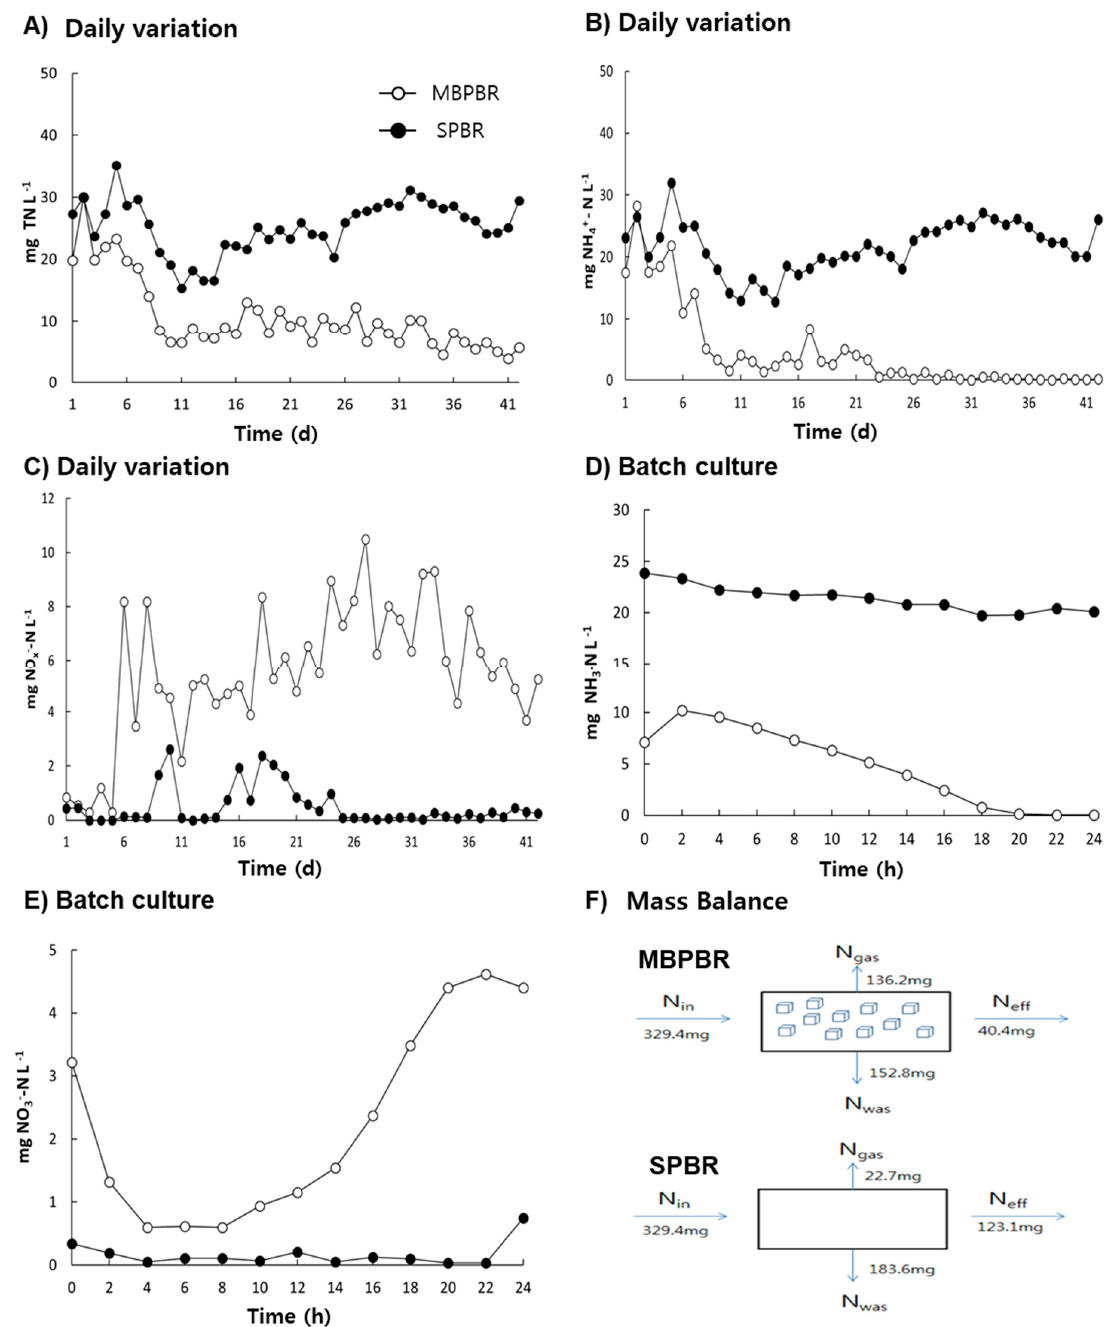
Figure 4. Daily variation in the effluent concentrations of total nitrogen (TN) ( A ), ammoniacal nitrogen (NH 3 -N) ( B ), and NO x − -N (sum of NO 2 − -N and NO 3 − -N) ( C ) from the photobioreactors (PBRs) during the operating days. Temporal variation in the effluent concentrations of NH 3 -N ( D ) and NO x − -N ( E ). Mass balance of nitrogen in the PBR with a moving bed (MBPBR) and PBR without a moving bed (SPBR) during the operating days ( F ). Measurements were conducted in triplicate and the mean values of the triplicates were